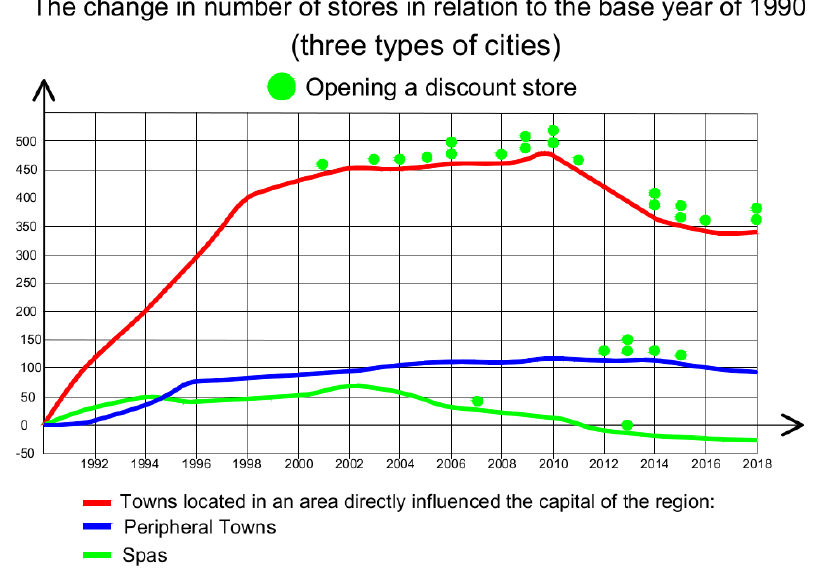
Figure 4. The change in number of stores in relation to the base year of 1990 in three types of cities.